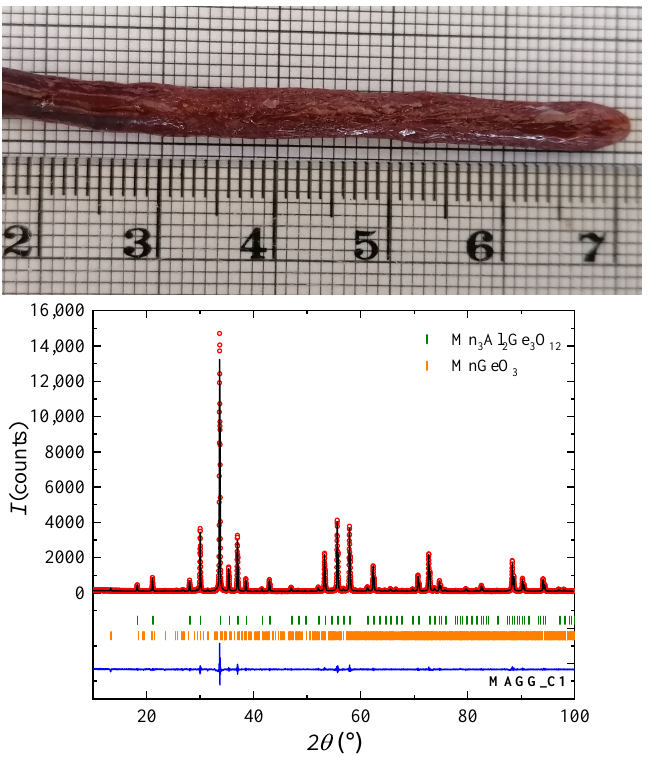
Figure 4. ( top ) As-grown crystal boule of Mn 3 Al 2 Ge 3 O 12 (sample labeled MAGG_C1) obtained in nitrogen gas atmosphere at a pressure of 3–3.5 bars and using a growth rate of 20 mm h − 1 . The feed rod was prepared using the starting polycrystalline Mn 3 Al 2 Ge 3 O 12 with a 15% excess of GeO 2 (same conditions used to synthesize the MAGG_3 sample). ( bottom ) PXRD profile of a ground crystal fragment isolated from the MAGG_C1 boule. The red open circles represent the experimental profile and the black line is the calculated profile, with the difference given by the blue line. The reflections of the Mn 3 Al 2 Ge 3 O 12 garnet structure are indicated by green “ (cid:120) ” while the reflections of the orthorhombic ( Pbca ) MnGeO 3 impurity are represented by orange “ (cid:120)